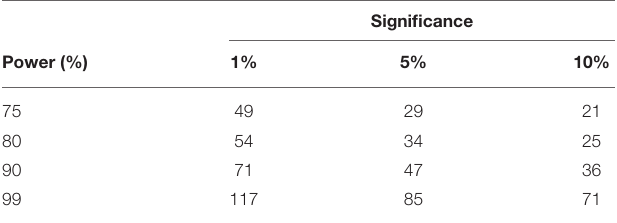
TABLE 5 | Required sample sizes to identify significant difference between treatment